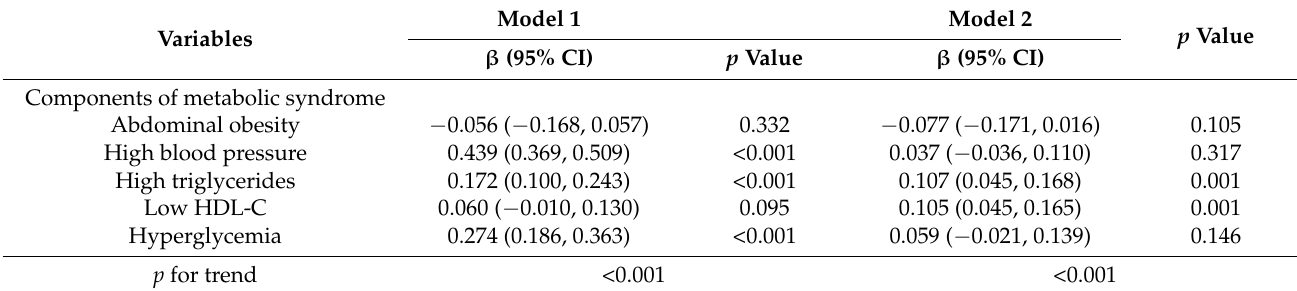
Table 3. Regression coefficients of each metabolic syndrome component for human epididymal protein 4